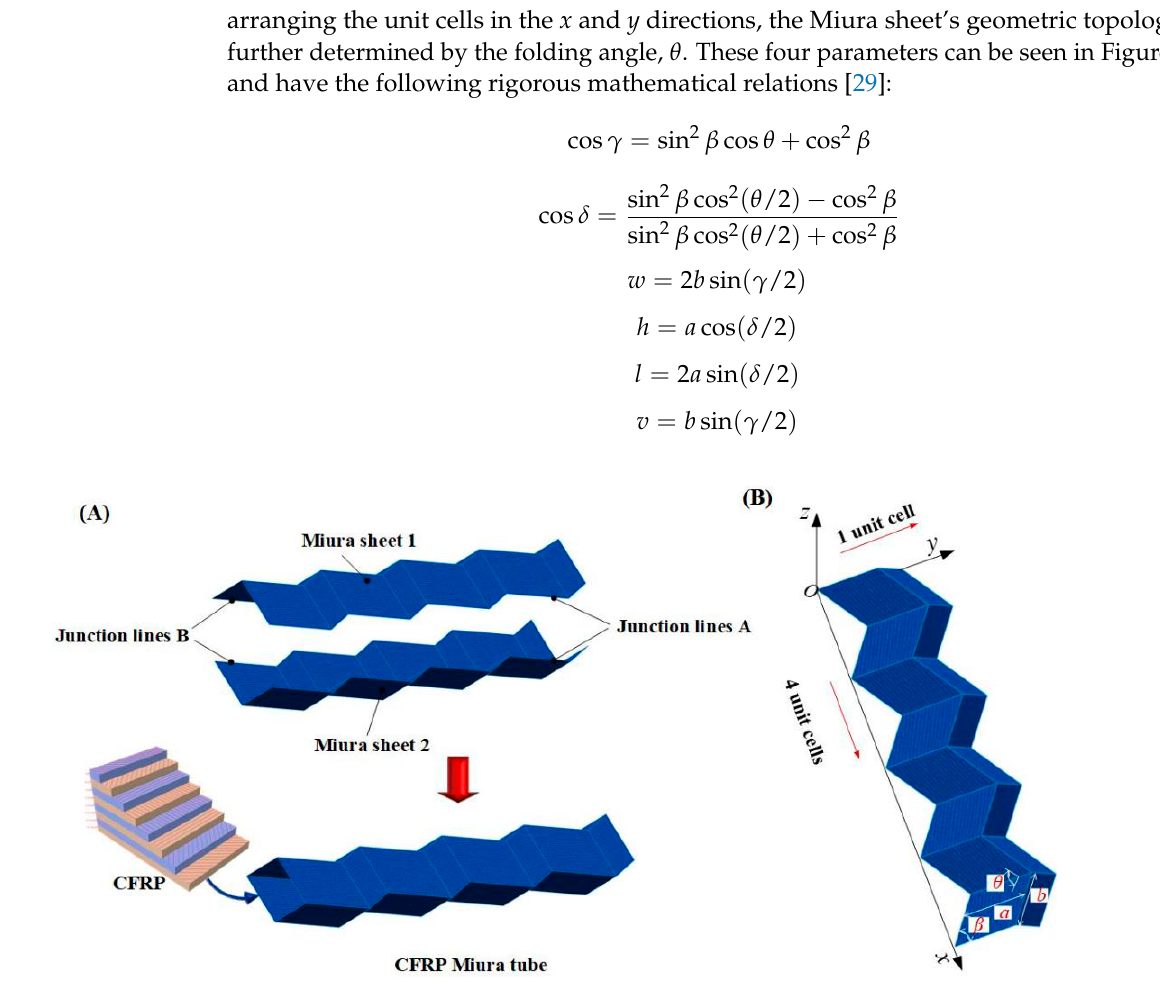
Figure 1. ( A ) Modelling of the CFRP Miura tube; ( B ) a typical Miura sheet with 4 by 1 unit cells.